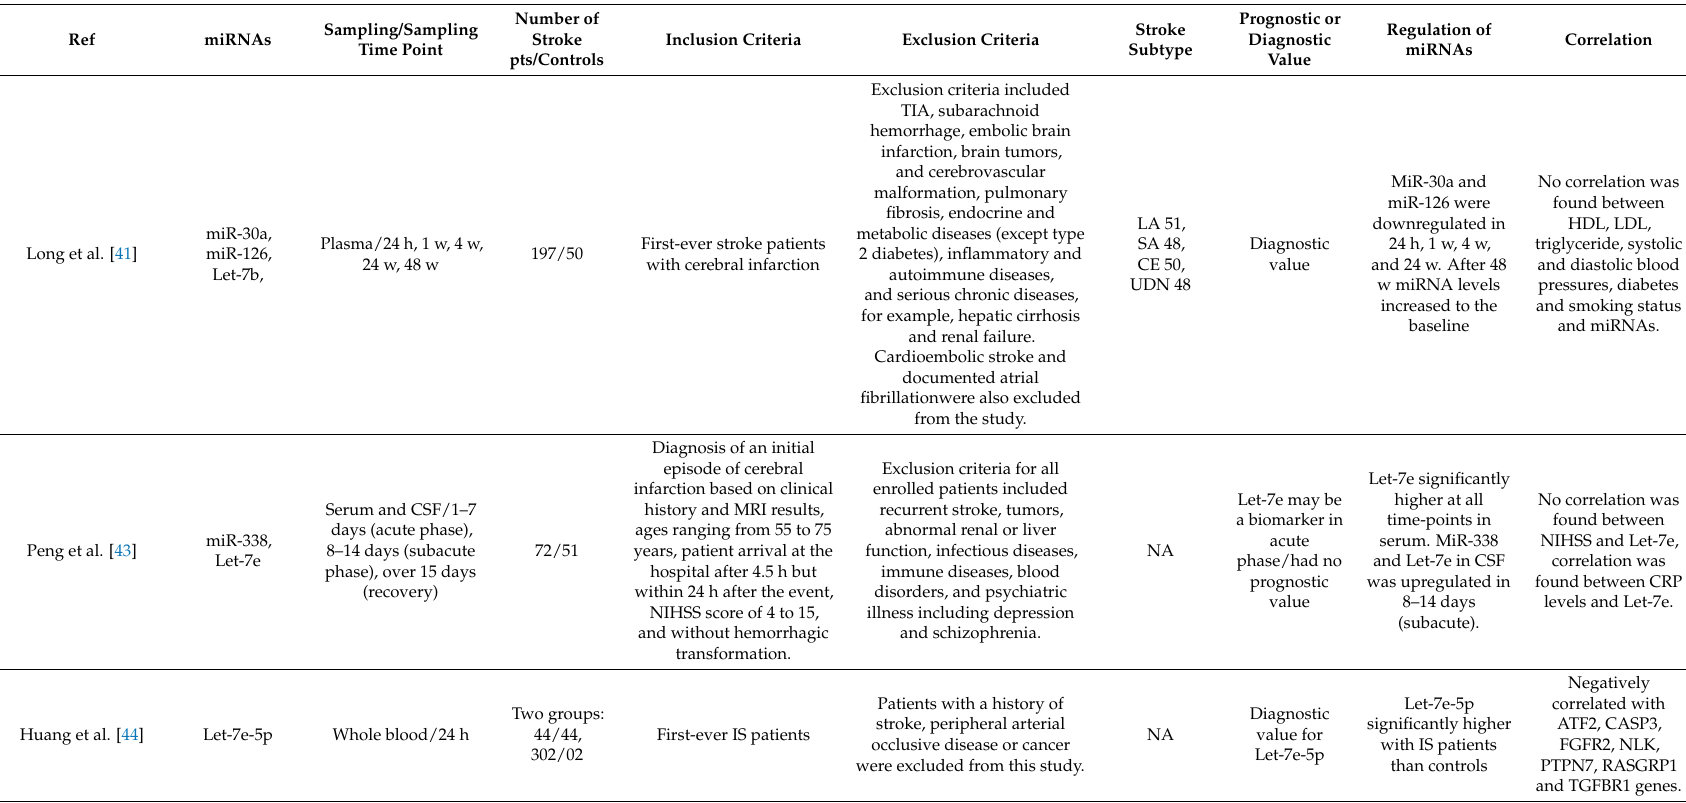
Table 1. Human studies evaluating miRNAs as diagnostic/prognostic biomarkers in